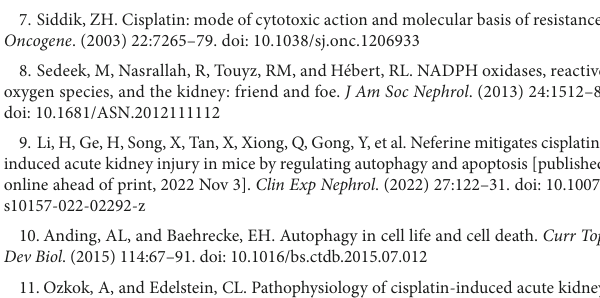
SUPPLEMENTARY FIGURE 2 Time course analysis neutrophil, macrophage, and dendritic cells from day 0 to day 3 of cisplatin injection in WT and NOX2 KO